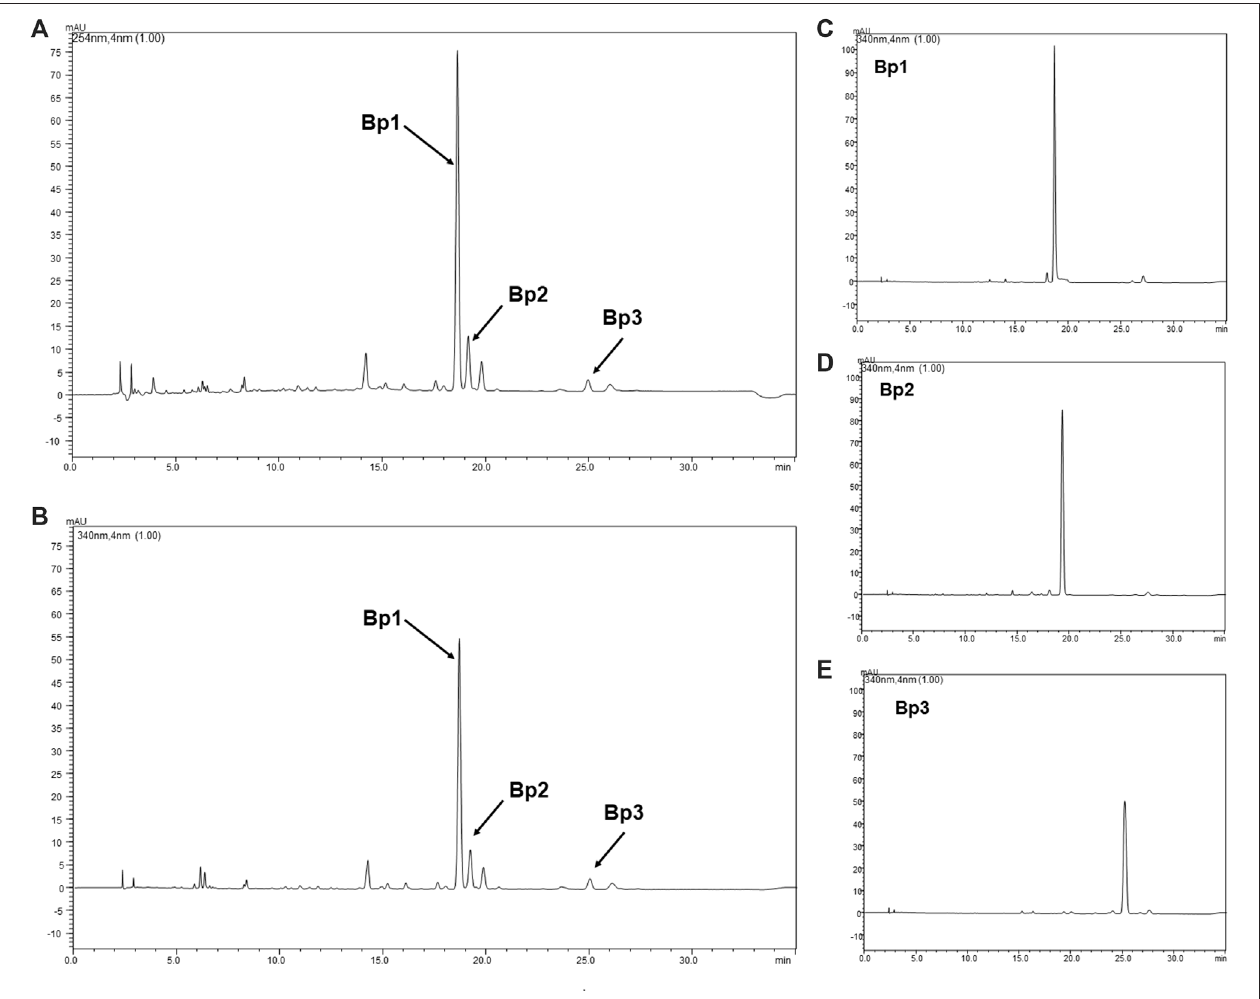
FIGURE1| Chromatogramof B.pinnatum extractatUV254nm (A) and340nm (B) andchromatogramatUV340 nmofBp1 (C) ,Bp2 (D) ,andBp3 (E) .Stationary phase: C18 Phenomenex (150 mm × 4.6 mm, 2.6 mm) equipped with a Phenomenex security guard column (4.0 mm × 2.0 mm ID). Mobile phase: tri fl uoroacetic acid 0.3% and acetonitrile; gradient: 7 – 15% B, 0 – 3 min; 15 – 20% B, 3 – 12 min; 20 – 22% B, 12 – 30 min; fl ow elution 0.7 ml/min; detection 254 and 340